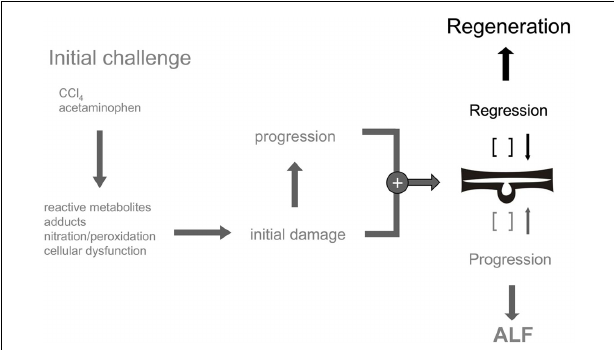
FIGURE 3 | Balance of tissue homeostasis after acute liver injury. The regenerative response of the liver after acute intoxication is triggered by the emergence of initial tissue damage and progression. Dependding on the dose of the noxa and the regenerative capacity of the hepatocytes injury regression and regeneration or progression and ALF